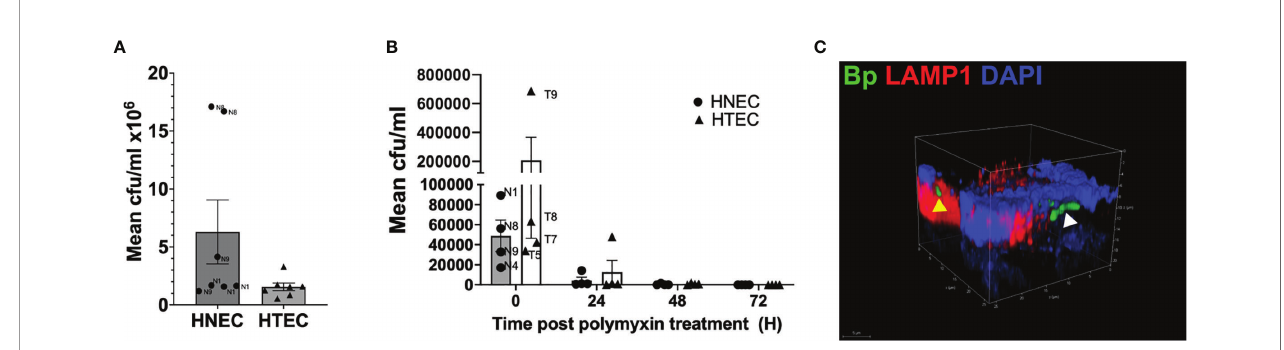
FIGURE 5 | Adherence, invasion and persistence of B . pertussis in airway mucosa models. Nasal (HNEC) and tracheo-bronchial mucosa tissue models (HTEC) were infected with wild type B . pertussis Tohama I (MOI: 50) for 24 h. (A) Barchart of B. pertussis- WT adherence to the HNEC and HTEC model at 24 h post infection. (B) The models were treated with polymyxin B (100 µg/ml) for 2 h. The models were washed and incubated with 10 µg/ml polymyxin B for an additional 24, 48, 72 and 96 h. The models were lysed with 1% saponin and the number of viable intracellular bacteria at the indicated time points were assessed by counting the CFU. Data are presented as means + SEM (error bars) of 3 independent experiments performed in duplicates (N=3). (C) Confocal image showing the B. pertussis (green) colocalized in acidic LAMP1 (yellow arrow head) endosome and nonacidic compartments (white arrow head) in